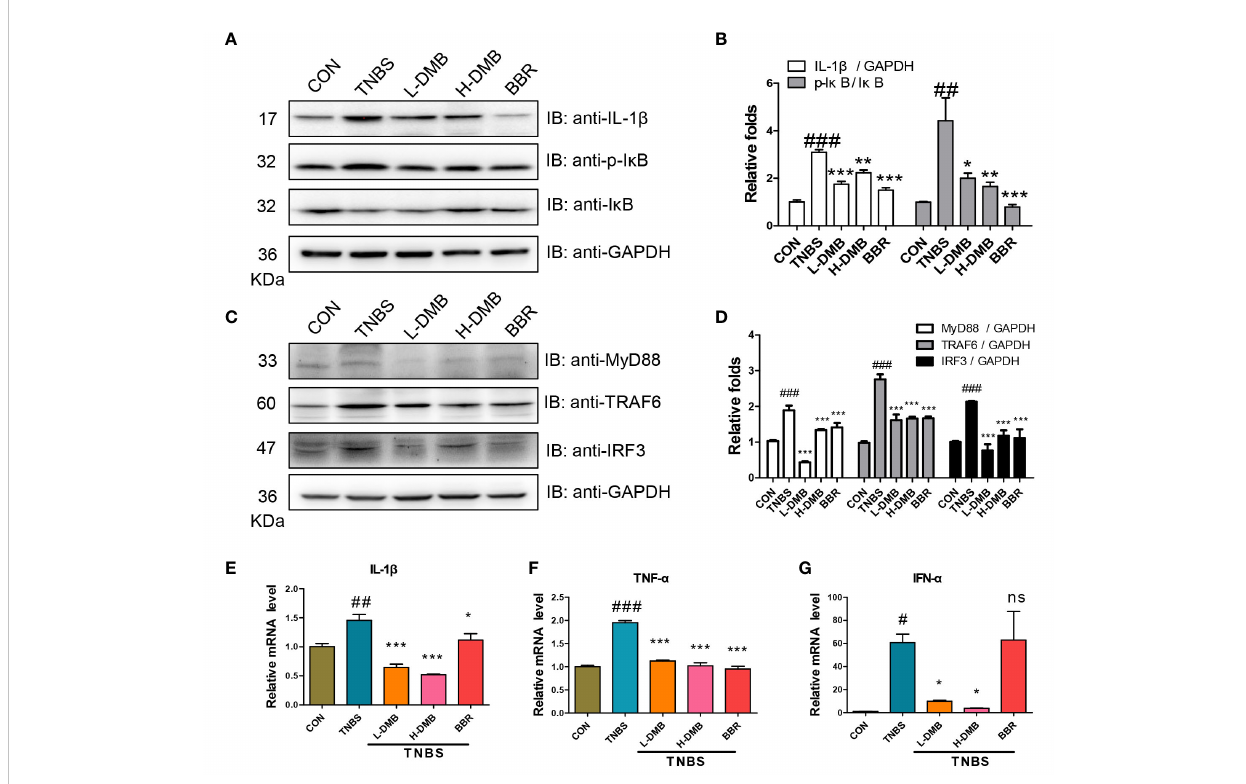
FIGURE 3 DMB inhibited TLR4 signaling in a MyD88-dependent and -independent manner. (A) The protein expressions were assessed by immunoblotting for IL-1 b , I k B, and p-I k B (Ser32) in colonic tissue; GAPDH served as reference. (B) The grayscale analysis of IL-1 b and the ratio of p-I k B/I k B. (C) The protein expression of MyD88, TRAF6, and IRF3 in colonic tissue; GAPDH served as reference. (D) The grayscale analysis of MyD88, TTRAF6, and IRF3. (E – G) The mRNA levels of IL-1 b , TNF- a , and IFN- a in colonic tissues. Statistical analysis was performed using one-way ANOVA. n = 3. # p < 0.05, ## p < 0.01, ### p < 0.005 (#: TNBS group versus the CON group) and * p < 0.05, ** p < 0.01, *** p < 0.005, ns, non-signi fi cantly (*: the DMB or BBR group versus the TNBS